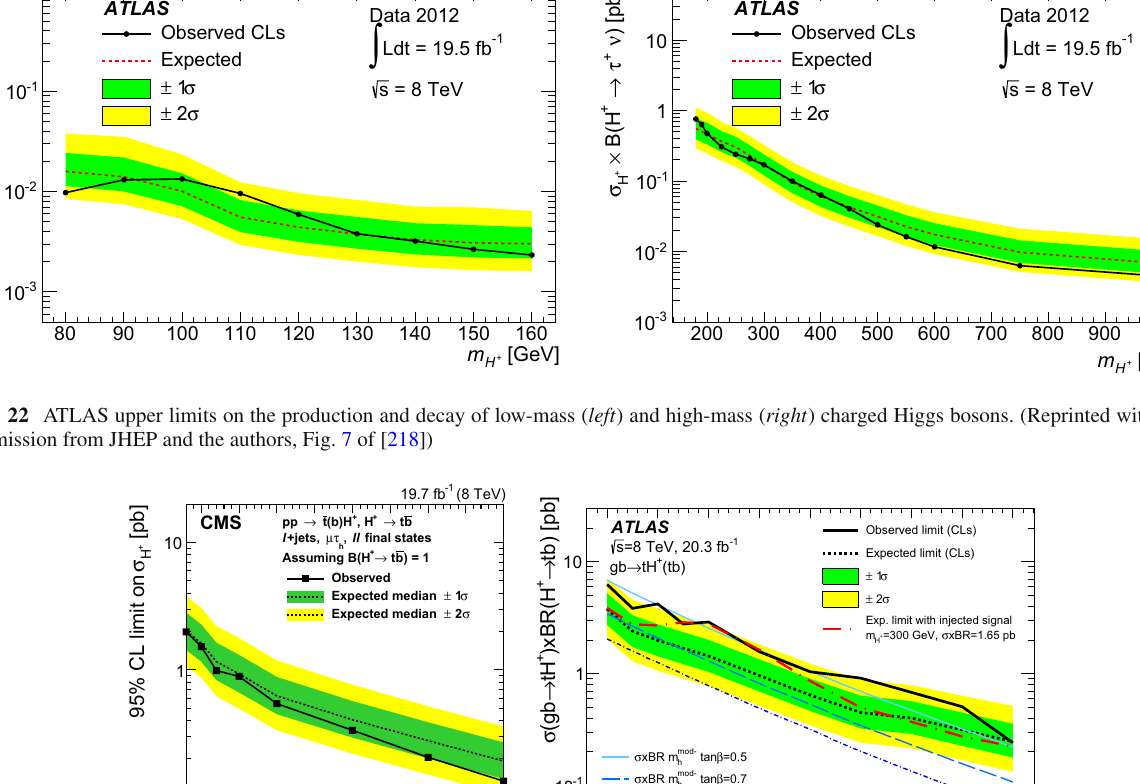
Fig. 24 ATLAS limits on the s -channel production cross section times branching fraction for H + → t ¯ b as a function of the charged Higgs-boson mass, for particular final states, using the narrow-width approximation. (Reprinted with kind permission from JHEP and the authors, Fig. 10 of